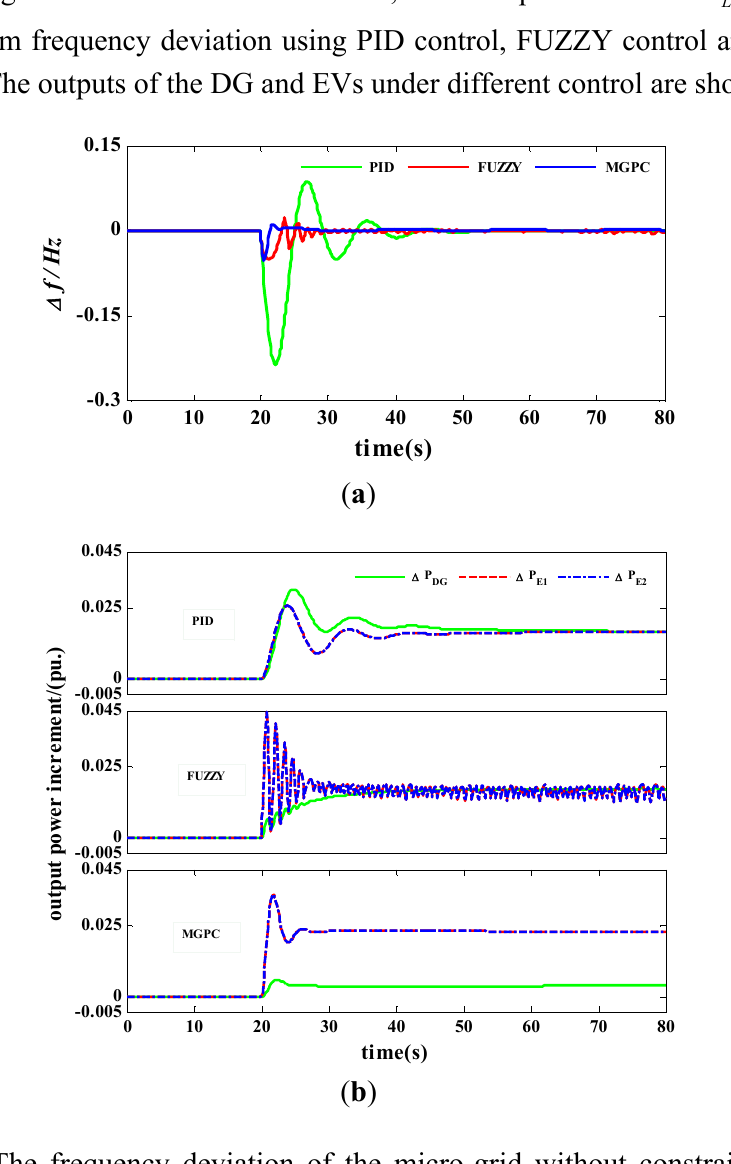
Figure 6. ( a ) The frequency deviation of the micro-grid without constraints using PID control, FUZZY control and MGPC control; ( b ) The output power increment of DG, EV1 and EV2 without constraints using PID control, FUZZY control and MGPC